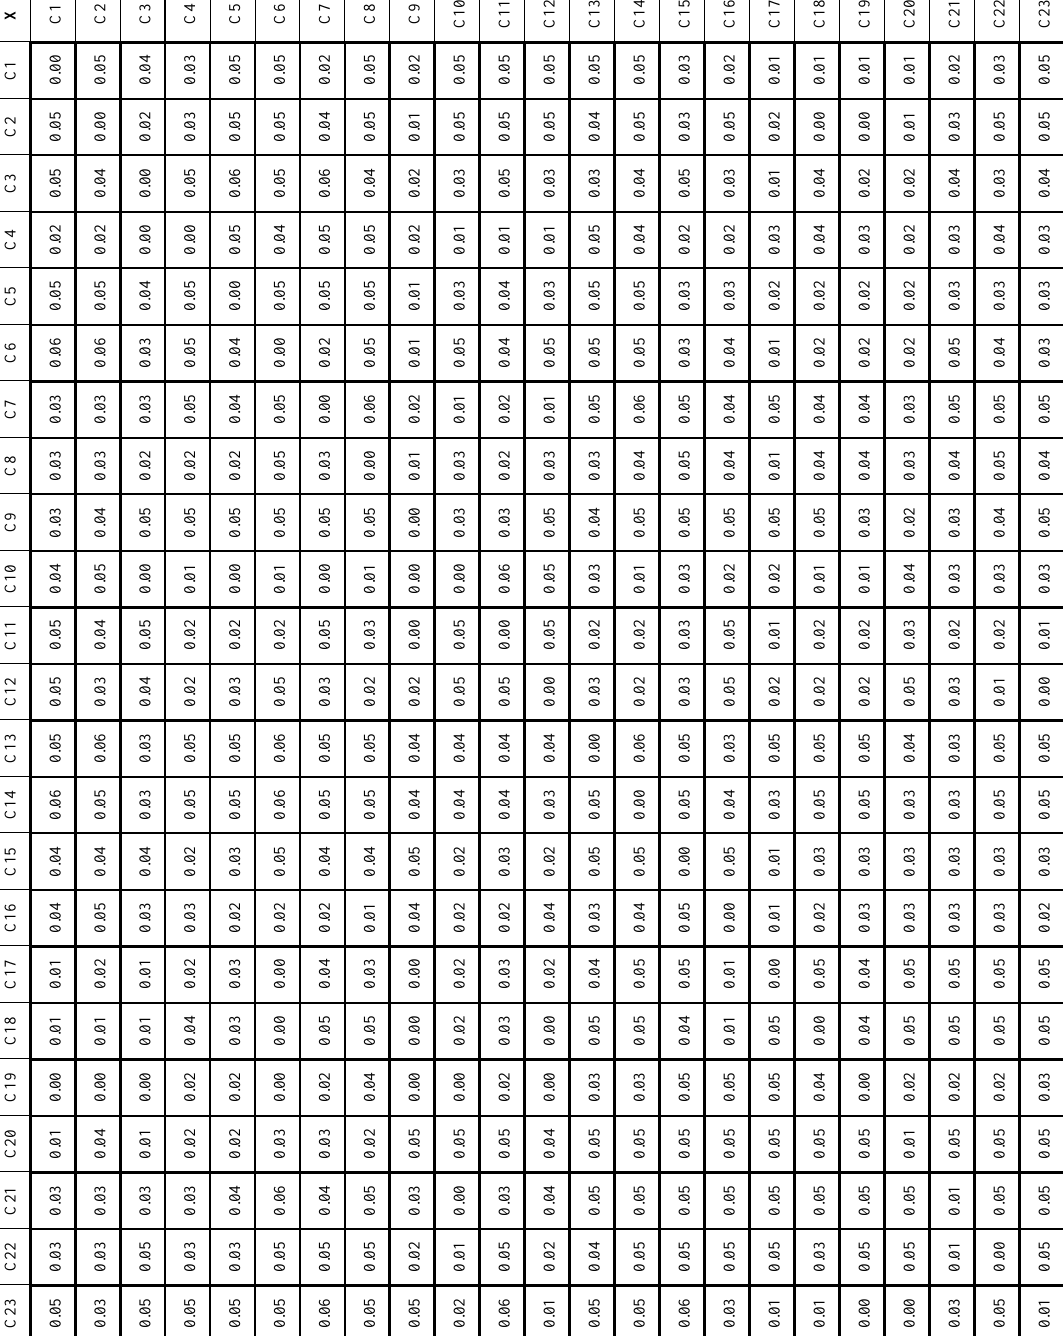
Table 13. Normalized direct relation matrix,